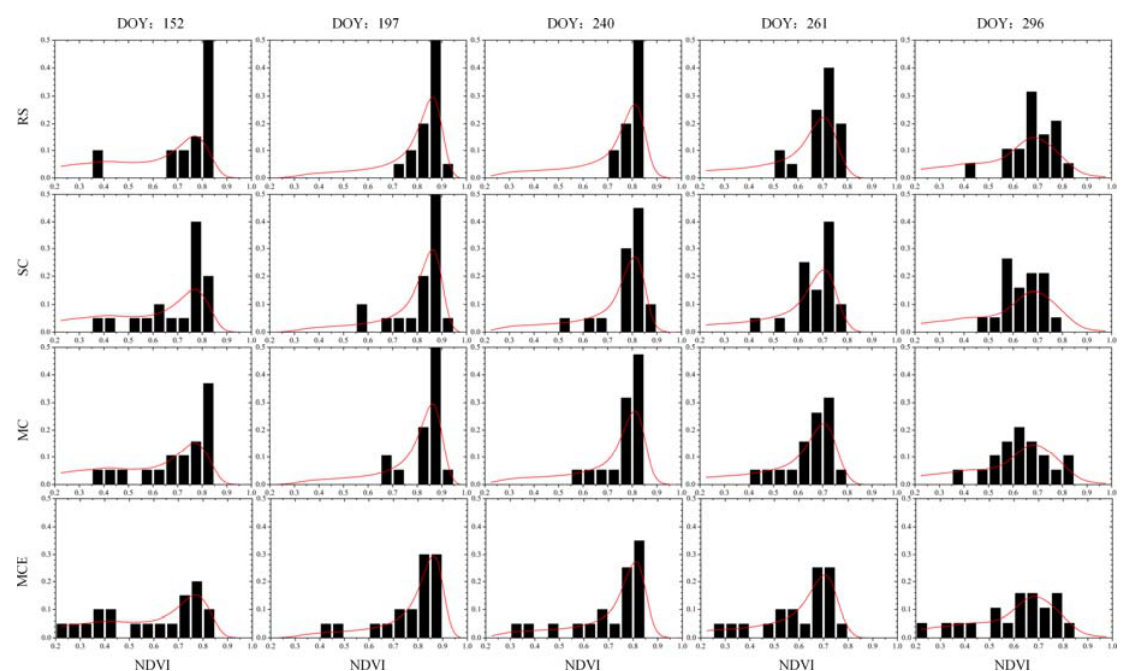
Figure 4. NDVI frequency distribution histograms of 20 selected elementary sampling units for the four sampling strategies (from top to bottom): random sampling (RS), single-temporally constrained sampling (SC), and multi-temporally constrained sampling (MC) in the feasible region (MC) and in the entire study area without the sampling feasible constraint (MCE). The red lines represent the NDVI frequency distribution histograms of the entire study area. Table 2. Overlapping area (OA, %) for random sampling (RS), single-temporally constrained sampling (SC), and multi-temporally constrained sampling applied to the feasible region (MC) and to the entire study area (MCE).